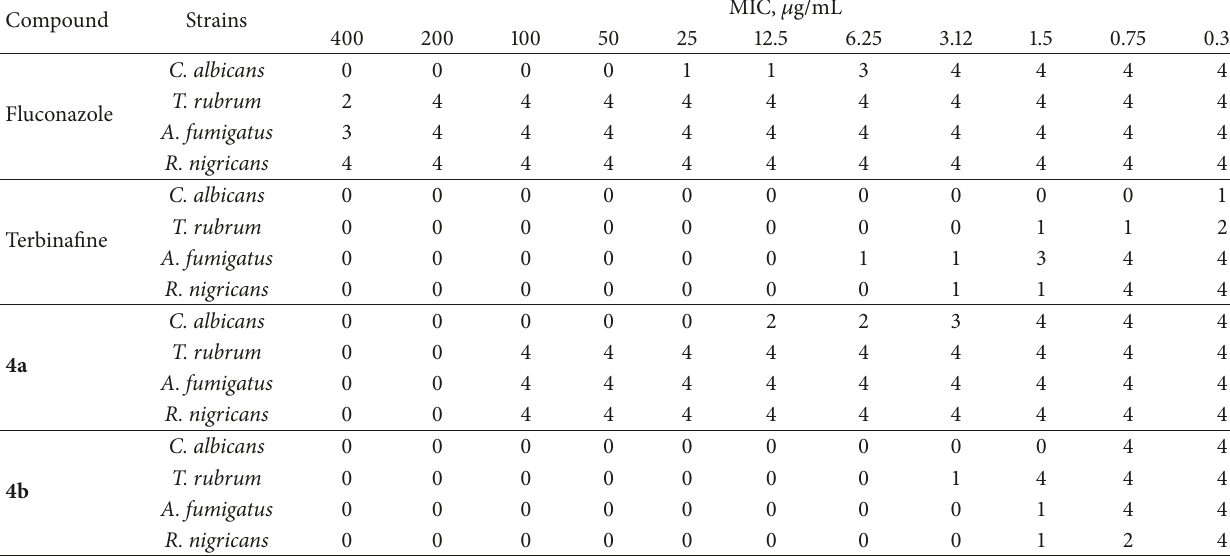
Table 1: Activity of compounds 4a,b on a panel of fungal